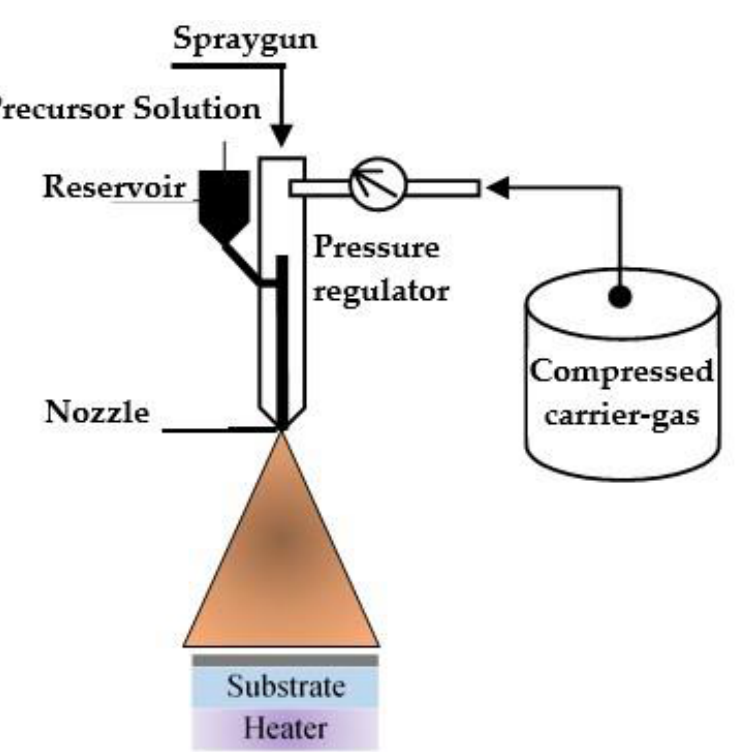
Figure 29. Pyrolytic deposition of EC films.